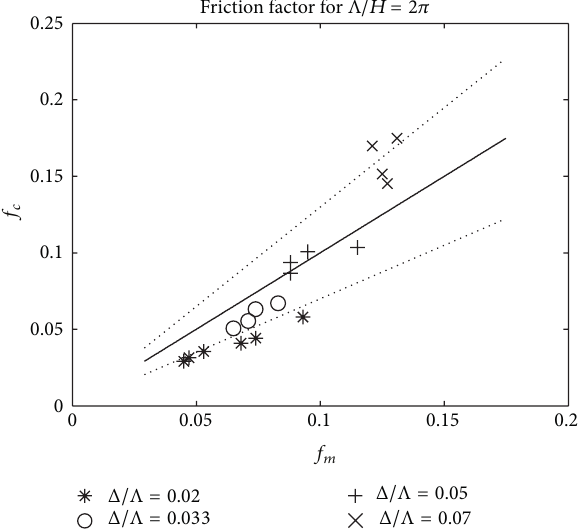
Figure 3: Comparison between measured [9] and calculated fric- tion factors. The dotted lines correspond to the 70% confidence